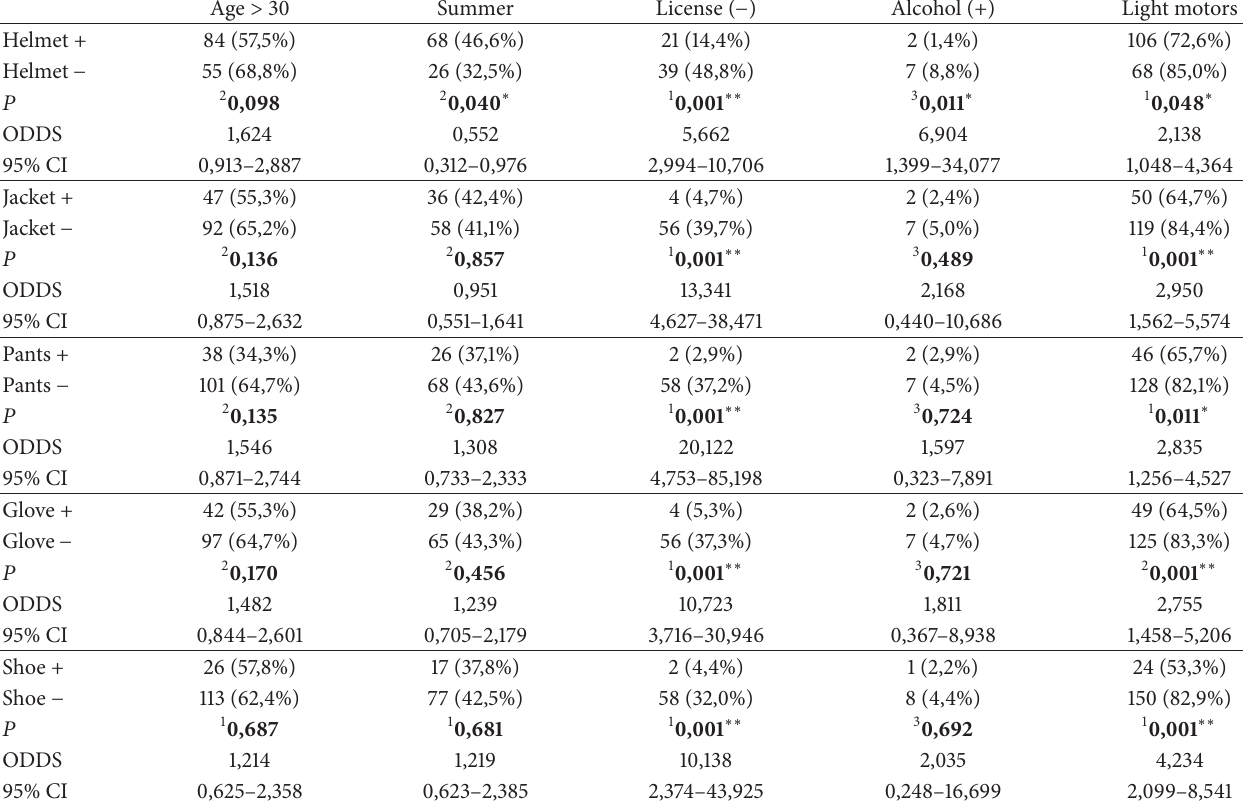
Table 3: Factors affecting protective clothes wearing ( 1 continuity correction (Yates) test, 2 Pearson’s chi-square test, 3 Fisher’s exact test, ∗ 𝑃 < 0.05 , and ∗∗ 𝑃 < 0.01